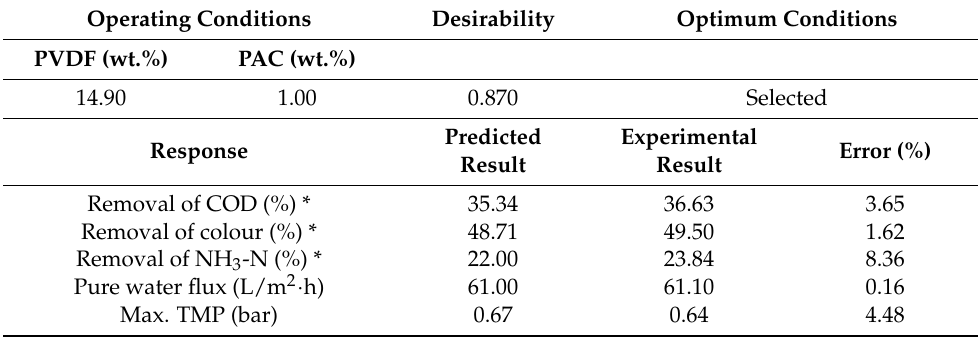
Table 7. Predicted and experimental removal efficiencies of the optimum PVDF-PAC membrane with the corresponding operating